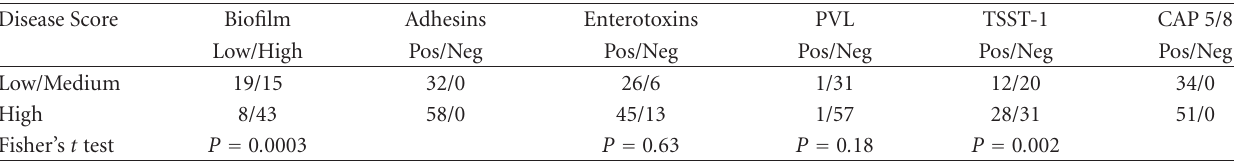
Table 5: Molecular characterization of bacterial virulence factors of S. aureus strains isolated in children with AD and disease severity. Disease Score